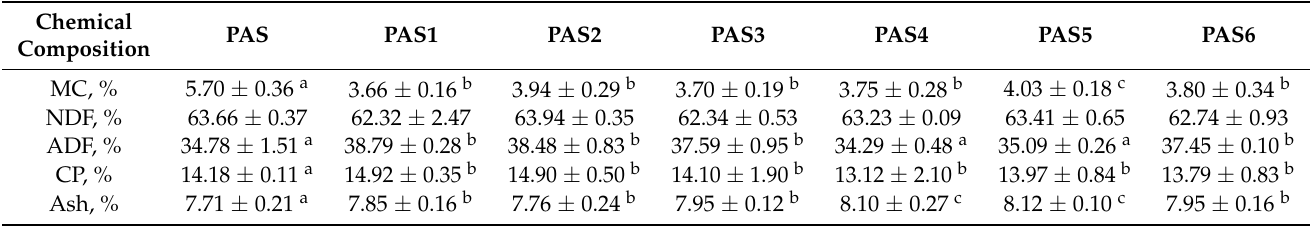
Table 1. Chemical composition of pineapple waste silage supplemented with different levels of fibrolytic